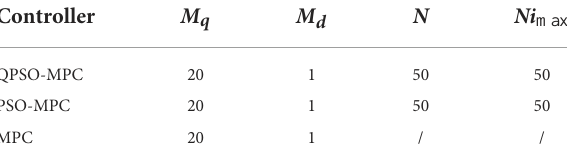
TABLE 1 The control parameters for the three